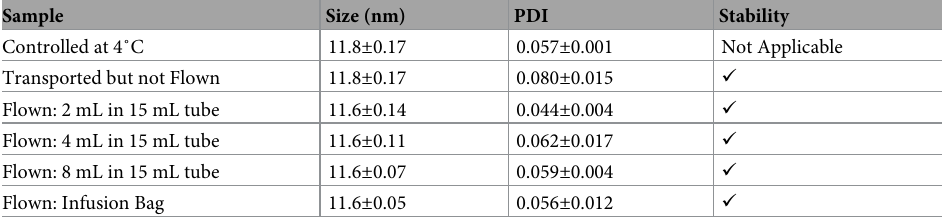
Table 2. Summary of DLS result of Bevacizumab at different storage conditions (trial 2).